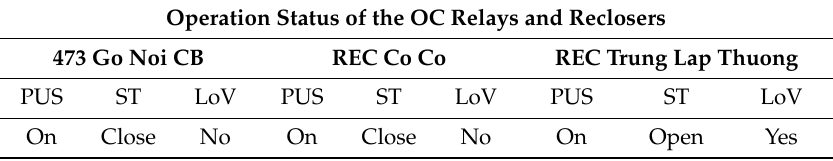
Table 20. The operation status of overcurrent relays and reclosers with a TPGF at F3. Operation Status of the OC Relays and